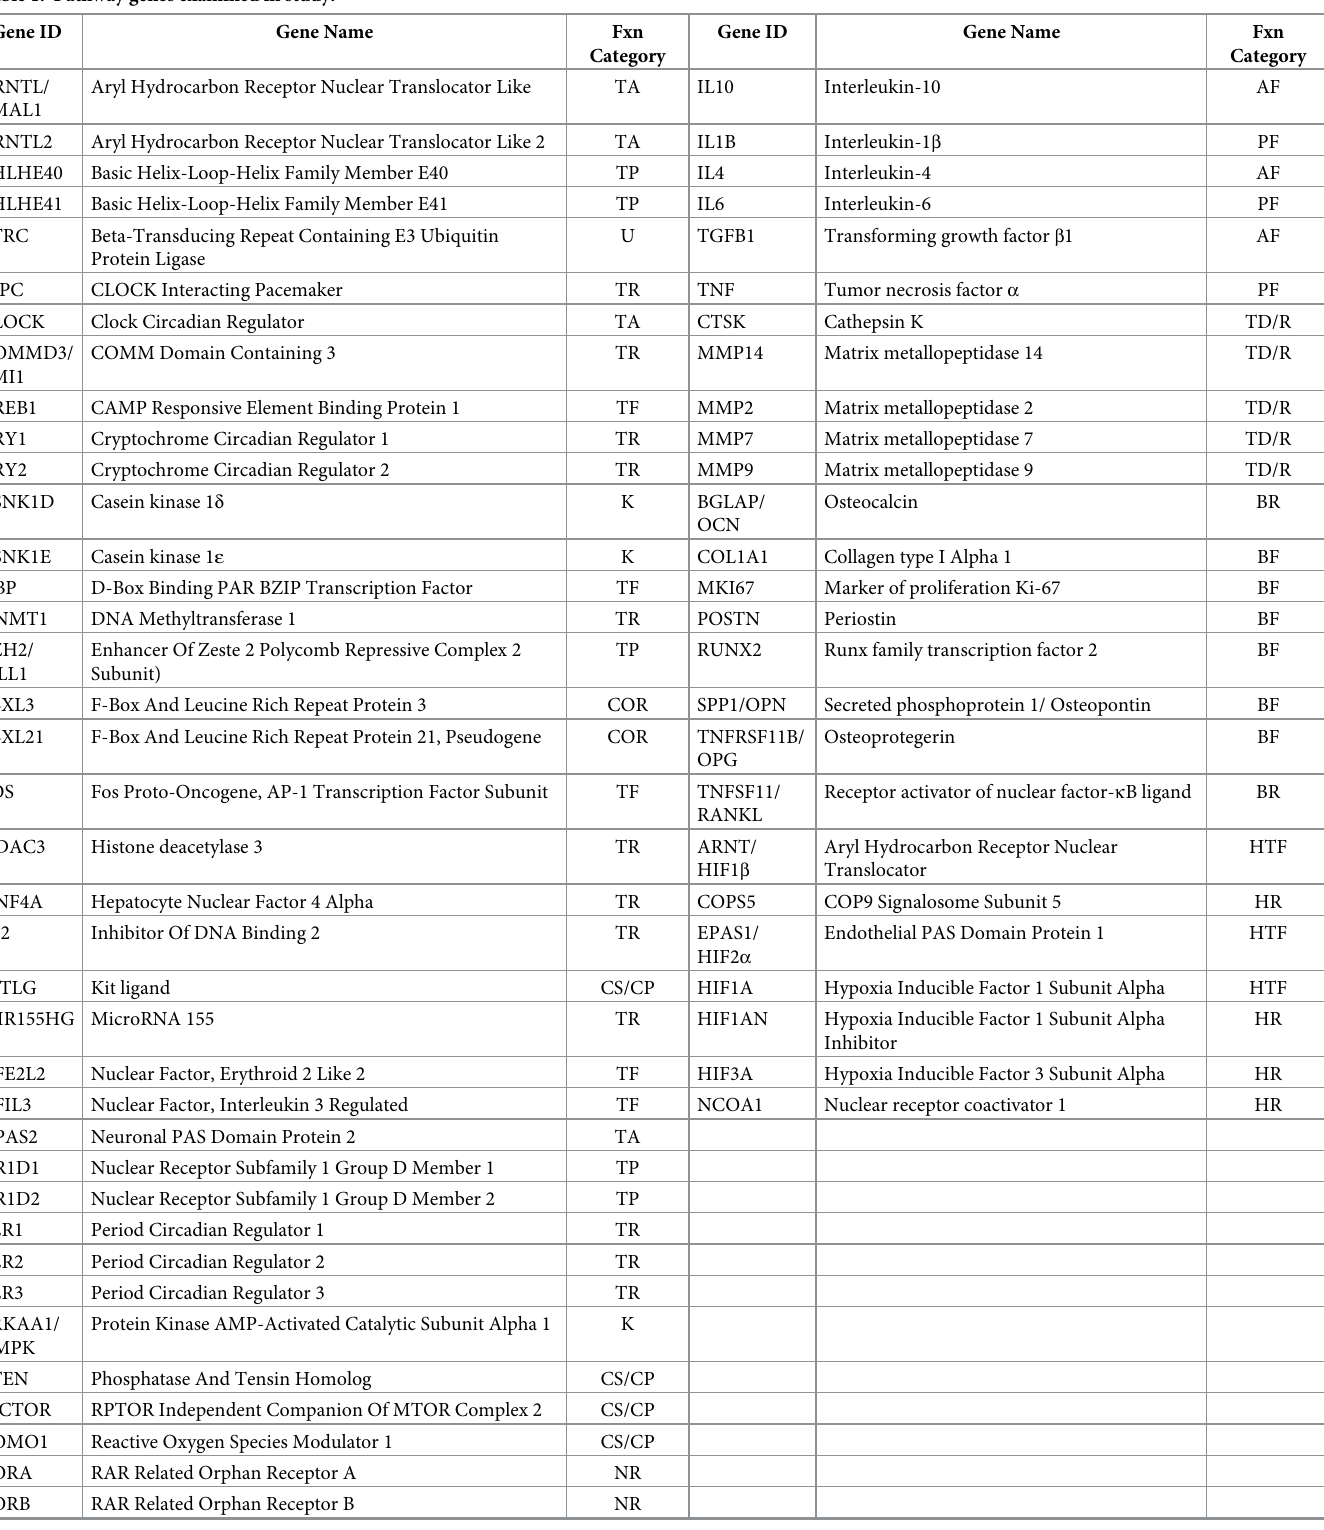
Table 1. Pathway genes examined in